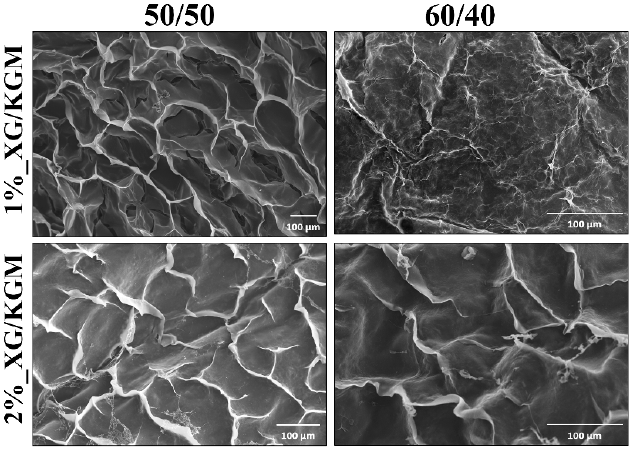
Figure 2. Representative scanning electron microscopy (SEM) images of the different ratios and percentages of XG/KGM used to produce hydrogels. Scale bar: 100 µm.